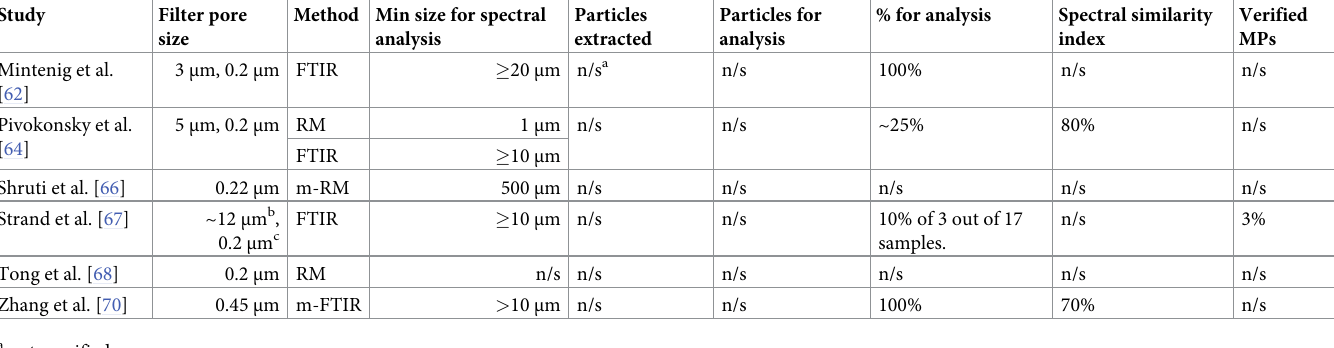
Table 2. Particle identification specifications for tap water